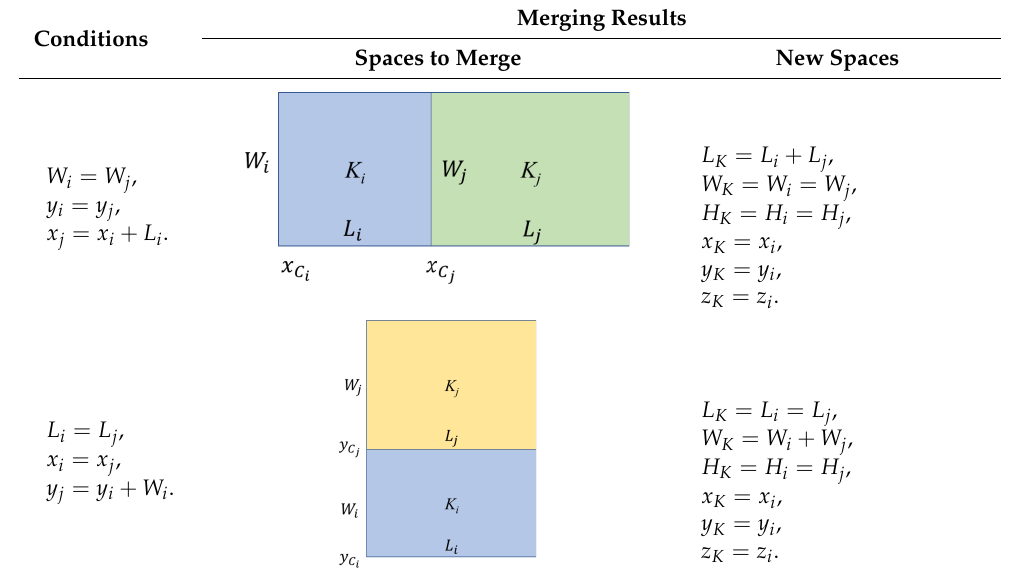
Table 3. Merging the main spaces to limit spatial fragmentation. Merging Results Conditions Spaces to Merge New Spaces